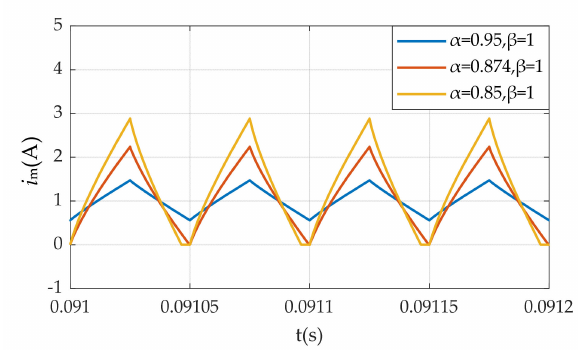
Figure 11. The inductor current when ( α , β ) = (0.95,1), ( α , β ) = (0.874,1) and ( α , β ) = (0.85,1).